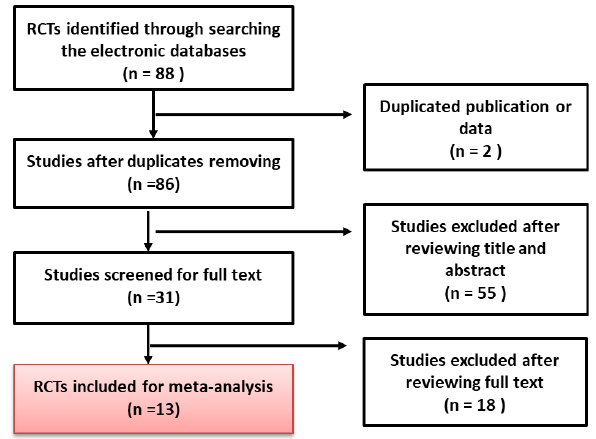
publication bias.